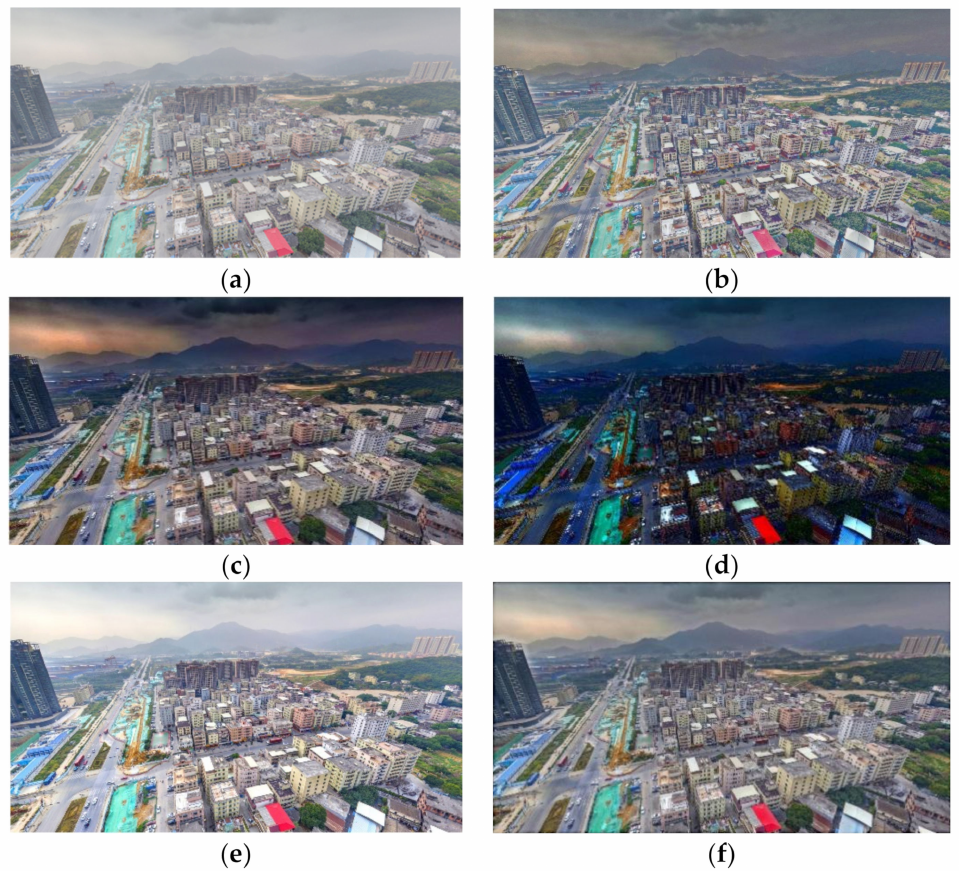
Figure 15. A comparison of defogging effects of foggy country images. ( a ) Image of foggy country